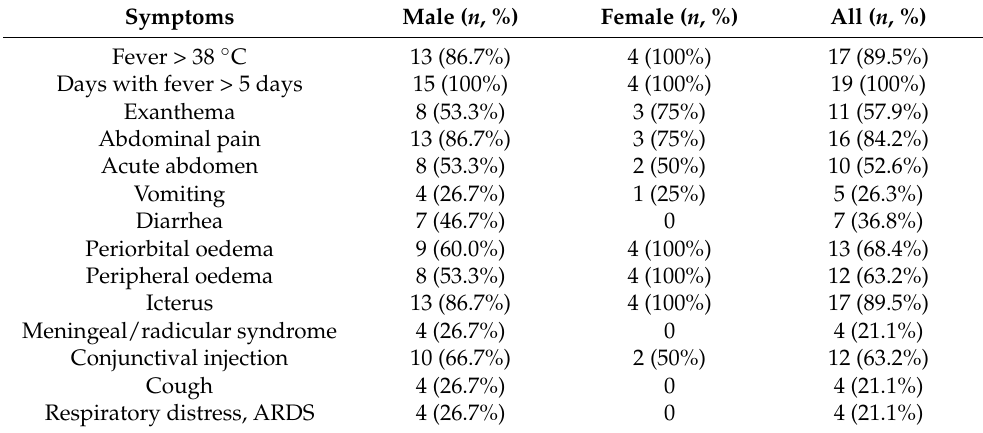
Table 1. Leading symptoms in MIS-C group of children and their distribution according to